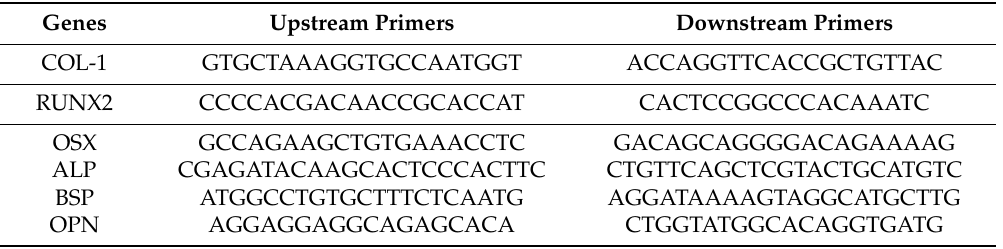
Table 1. The primer sequences of the upstream and downstream primers for these mRNA analyses (5 (cid:48) to 3 (cid:48)